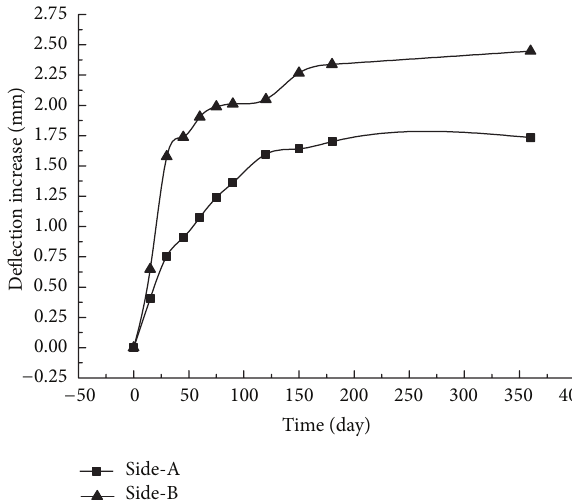
Figure 18: The relationship between the deflection increment of the midspan on both sides of the truss structure and time.